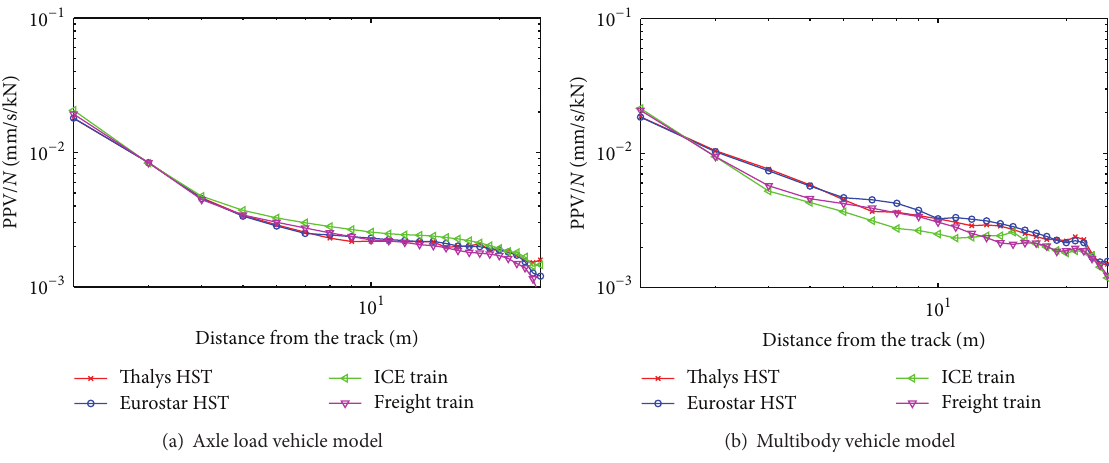
Figure 12: Comparison of PPV /𝑁 indicators related to the studied trains for a vehicle speed of 150